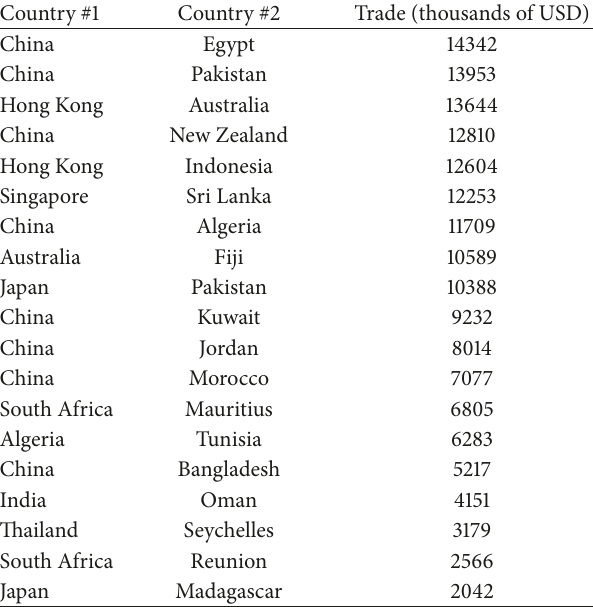
Table 3: Asia-Africa-Oceania metal manufactures trade in 1994 (from